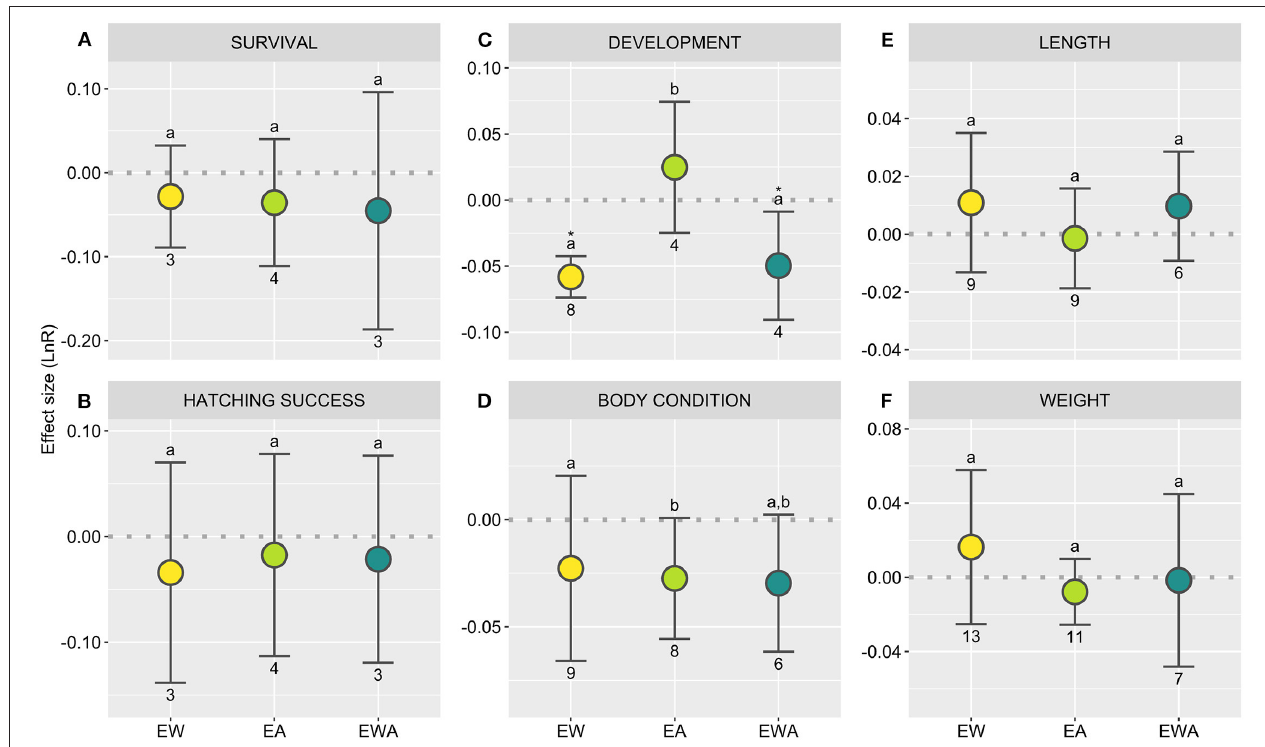
FIGURE 4 | Directional effect size (LnR) of experimental warming (EW), acidification (EA), and their combination (EWA) over elasmobranchs, considering specific biological responses [ (A,B) survival; (C) development; (D–F) growth]. The dashed line ( R = 0) represents the threshold used to test the null hypothesis, with overlapping confidence intervals (CI) indicating the lack of significant treatment effect. R values above 0 indicate a stimulation and below indicates an inhibition of the response; asterisks indicate a significant effect. Different letters showcase differences between treatments; numbers indicate sample sizes (number of control-treatment contrasts). Statistical results are detailed in Supplementary Table 3